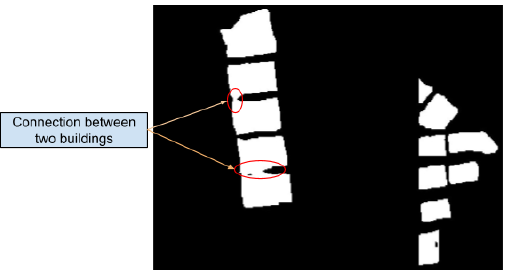
Figure 2 . 3 : Connection / binary bridge between buildings